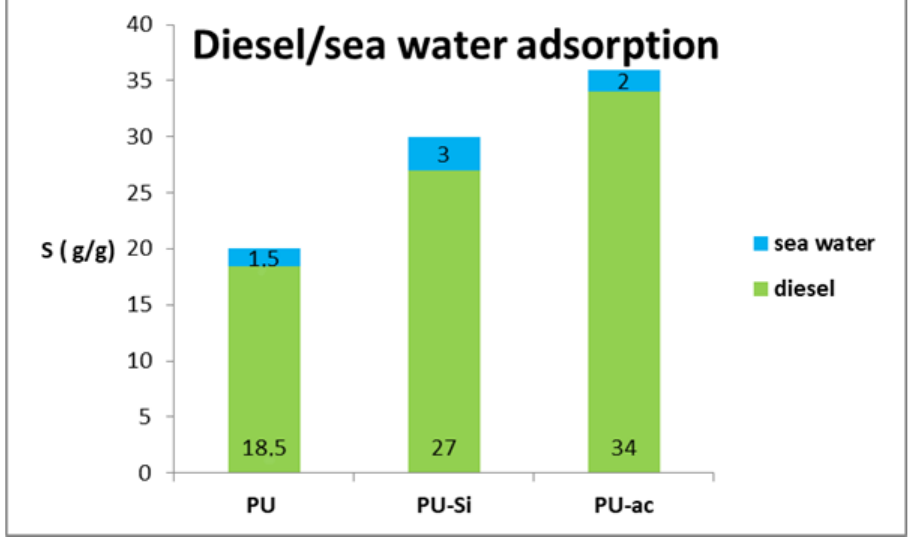
Figure 11. Total adsorption capacity for the three types of materials, 1–3 , tested with respect to diesel and sea